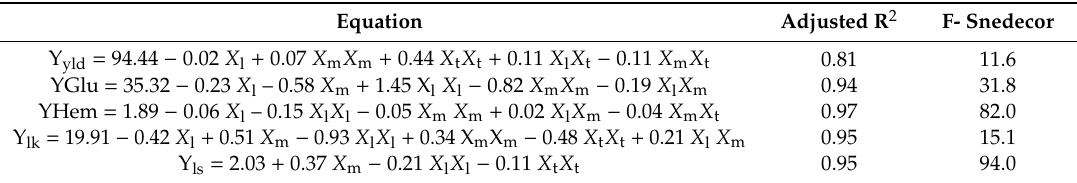
Table 3. Equations obtained for each dependent variable of autohydrolysis + enzymatic process after autohydrolysis process. Dependent variables: Yyld: enymatic yield (%); YGlu: glucan (%); YHem: hemicelluloses (%); Ylk: klason lignin (%); Yls: acid-soluble lignin (%). Independent variables: X l : laccase concentration; X m : HBT concentration; and X t : operation time.